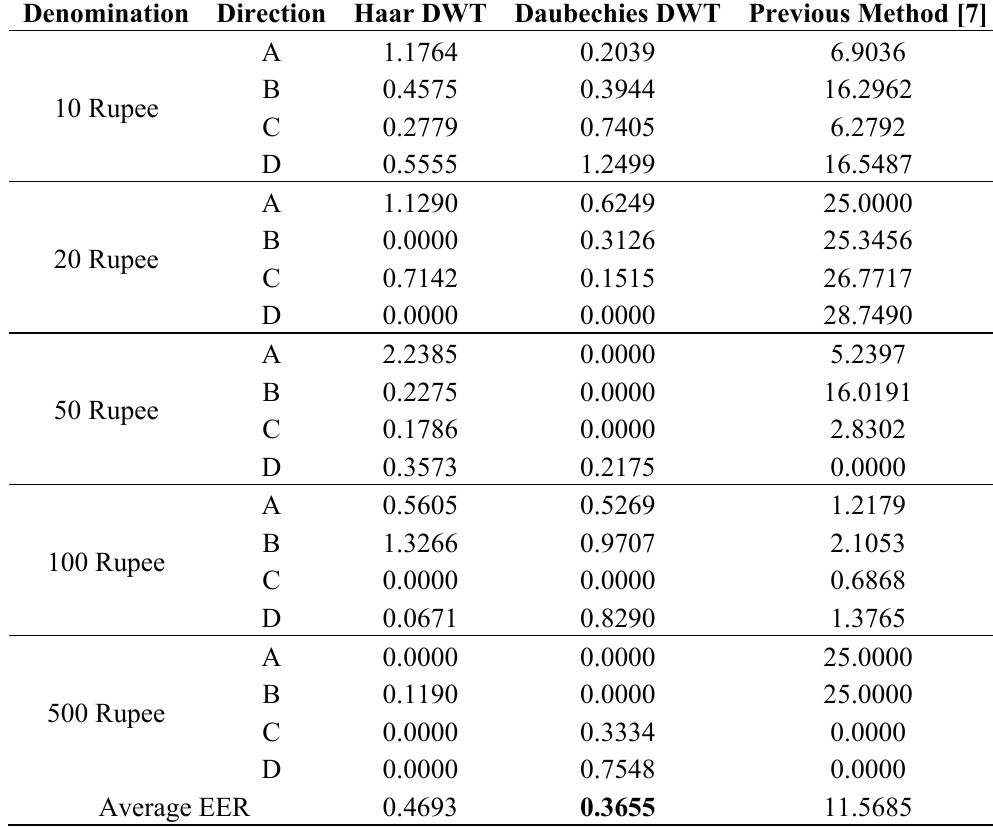
Table 7. Comparison of average EERs by our method with those by previous methods (unit: